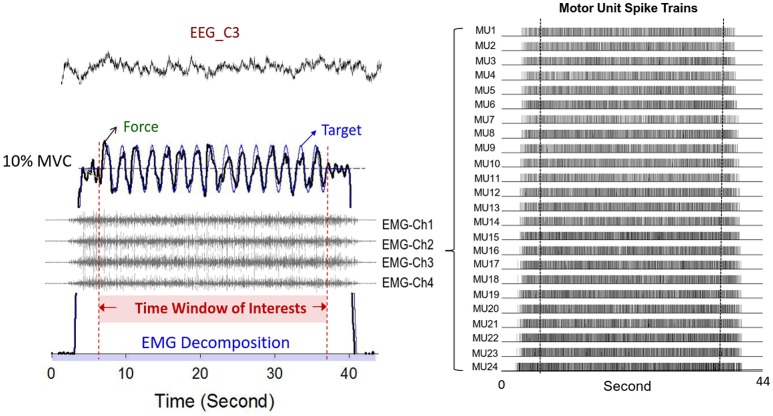
Typical recording of physiological data. Only force data, discharge variables, and EEG of the contralateral motor cortex in the time window of interest were presumably stable. The multi-channel surface EMG were decomposed to a number of motor unit spike trains with a state-of-the-art computational principle.